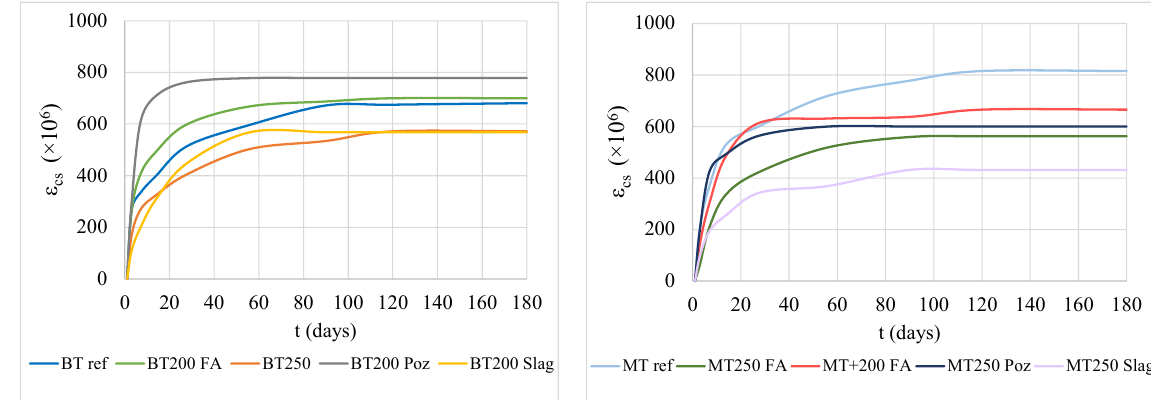
Figure 3. Shrinkage evolution of BT (left) and MT (right) mixtures with time.